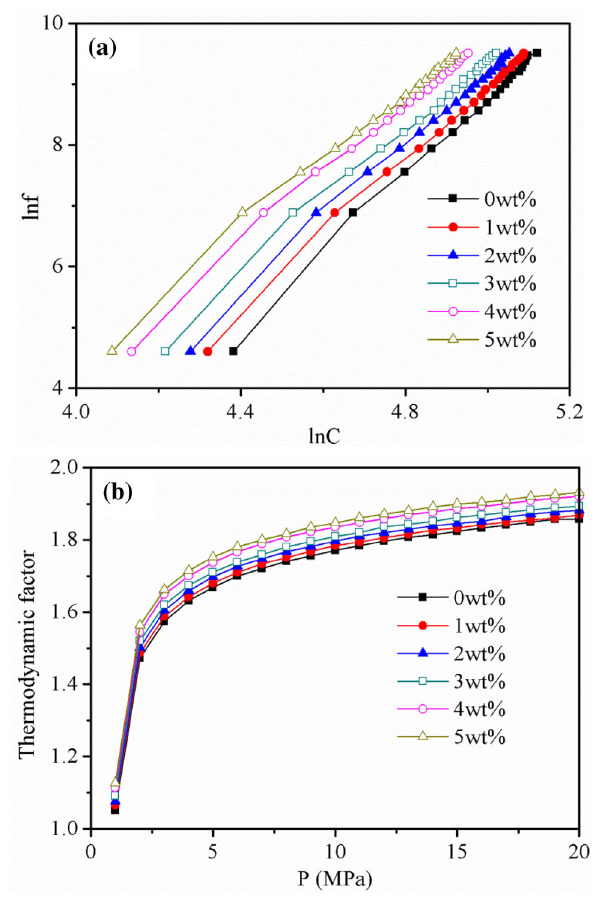
Fig. 6 a lnf versus lnC; b thermodynamic factor with different water content against pressure